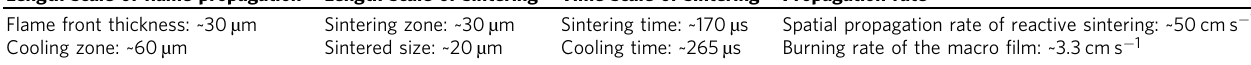
Table 1 Summary of different length and time scales in this study Length scale of fl ame propagation Length scale of sintering Time scale of sintering Propagation rate Flame front thickness: ~30 µ m